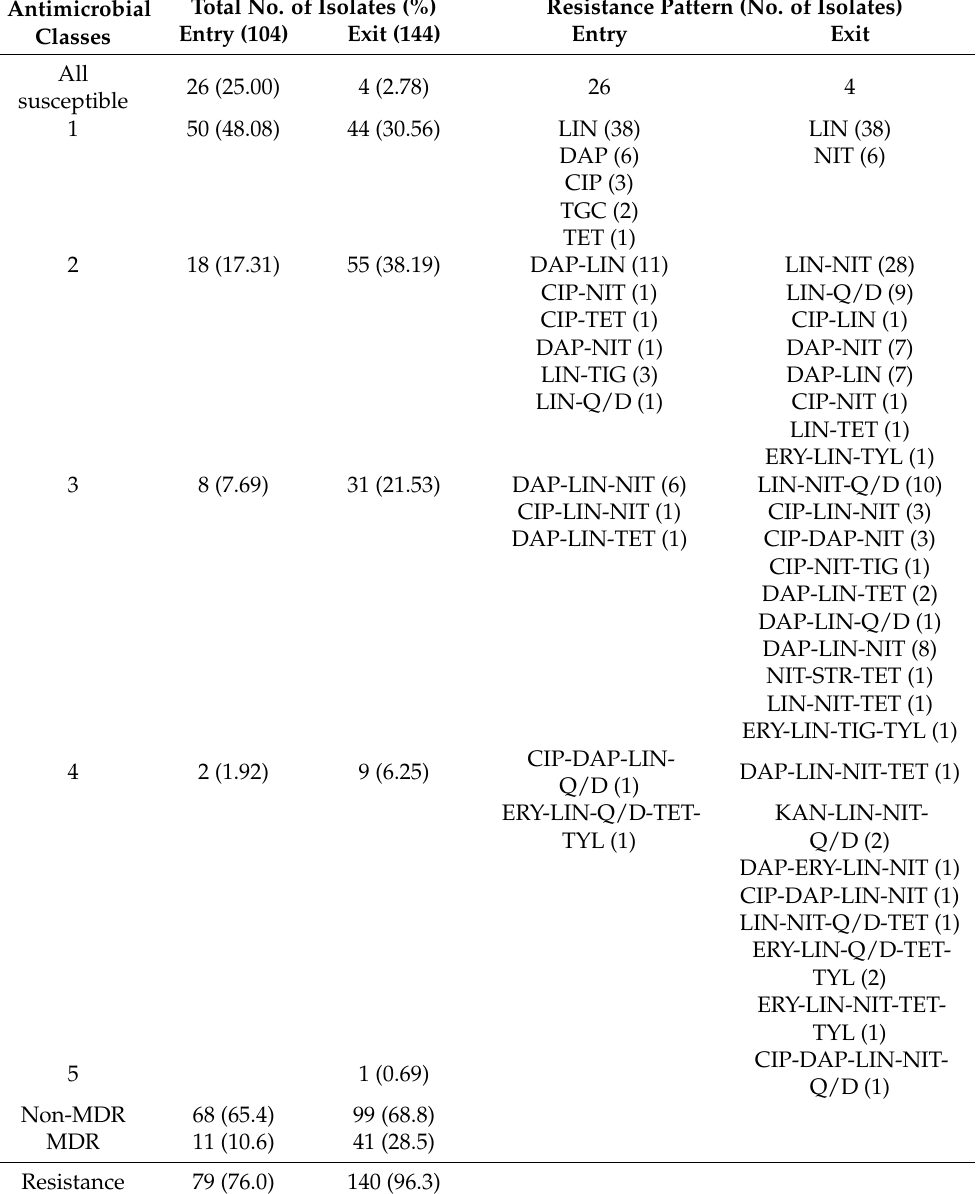
Table 4. Antimicrobial resistance profiles identified among Enterococcus spp. isolated from rectal faecal samples obtained at entry and exit from an Australian